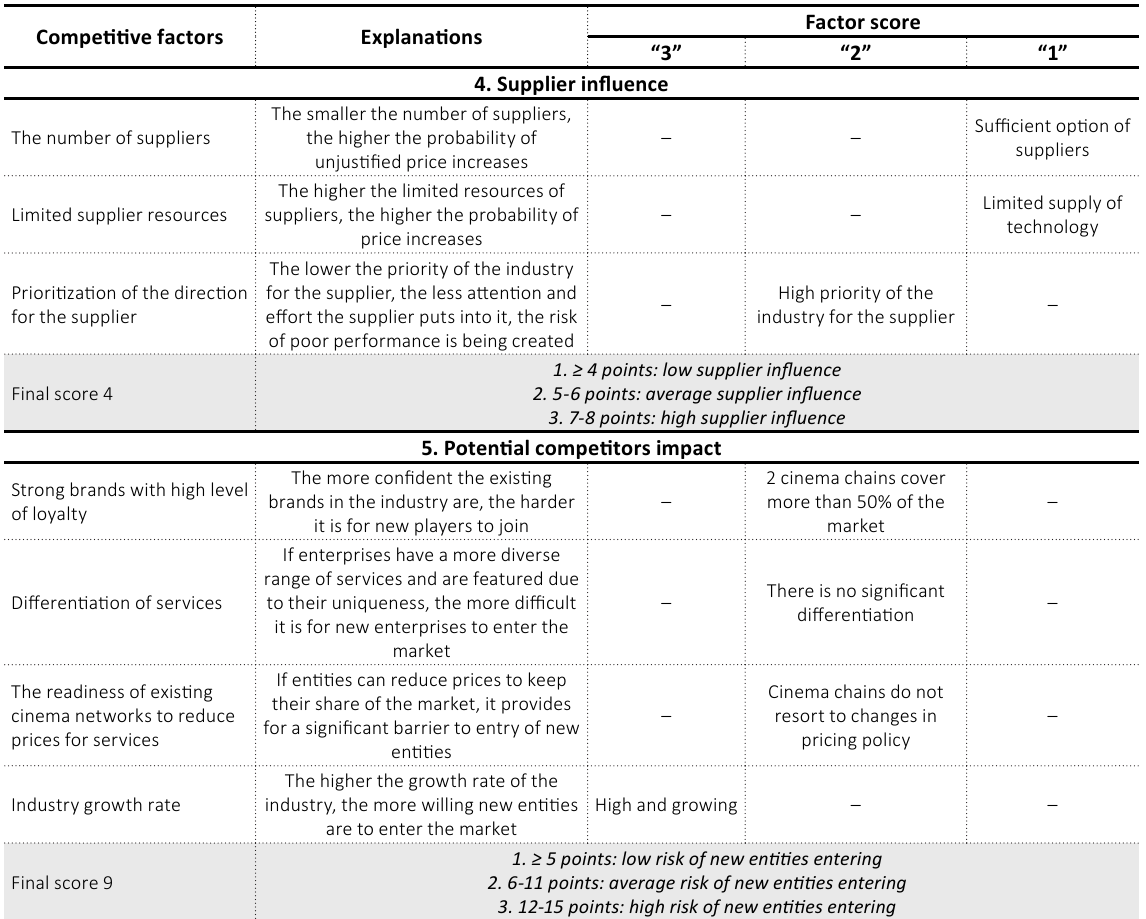
Table 1 (cont.). Competitive analysis of cinema chains by Porter’s Five Forces Framework